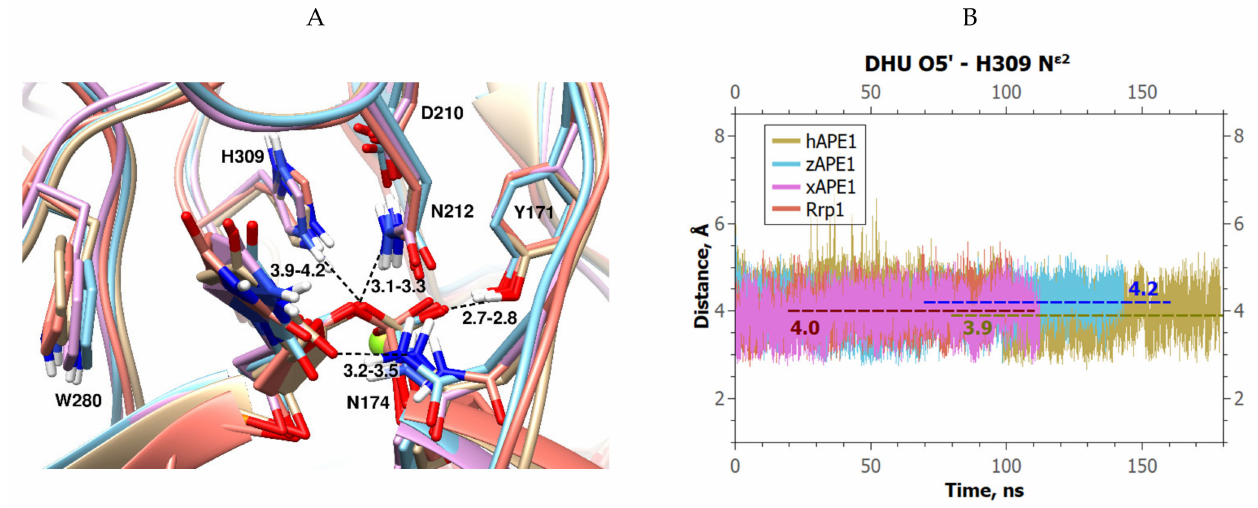
Figure 4. MD trajectories and structures of the complexes of APE1-like endonucleases with DHU- containing DNA: ( A ) Structural models of enzyme–substrate complexes with average lengths of H-bonds (hAPE1 is sand-colored, zAPE1 is cyan, xAPE1 is magenta, and Rrp1 is red). The average lengths of H-bonds between His309 N ε 2 and DHU O5 (cid:48) , between Asn212 N δ 2 and DHU O5 (cid:48) , between Asn174 N δ 2 and DHU O2, and between Tyr171 O η and DHU O2P are given; ( B ) Changes in DHU O5 (cid:48) –His309 N ε 2 distances in different complexes throughout the MD trajectories for the analyzed complexes of APE1-like enzymes with DHU-containing